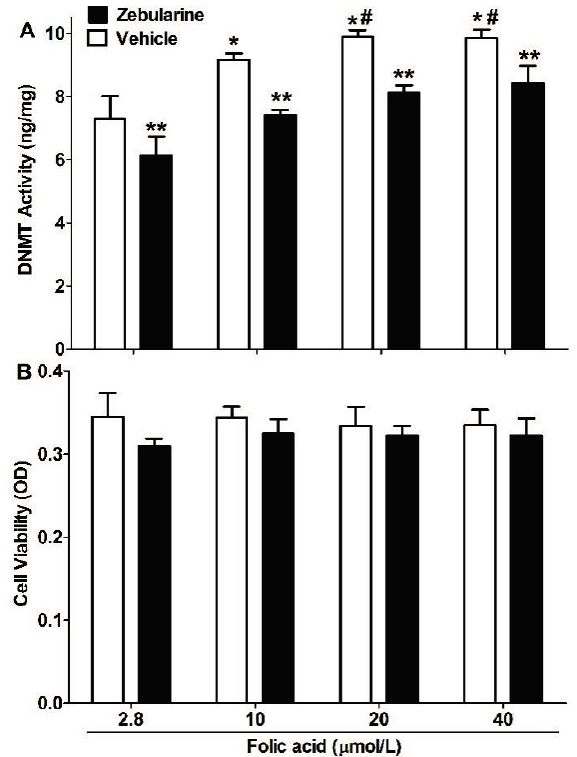
Figure 3. Folic acid raises and zebularine lowers DNMT activity, without altering cell viability. N2a-APP cells were incubated as described in Figure 1. ( A ) DNMT activity in nuclear extracts; ( B ) Cell viability based on Alamar blue assay. The plotted values are mean ± SEM values for 3 experiments. * p < 0.05 compared with 2.8 μ mol/L. # p < 0.05 acid